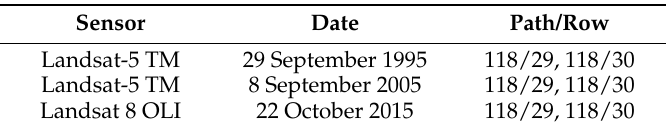
Table 1. The satellite data used in the